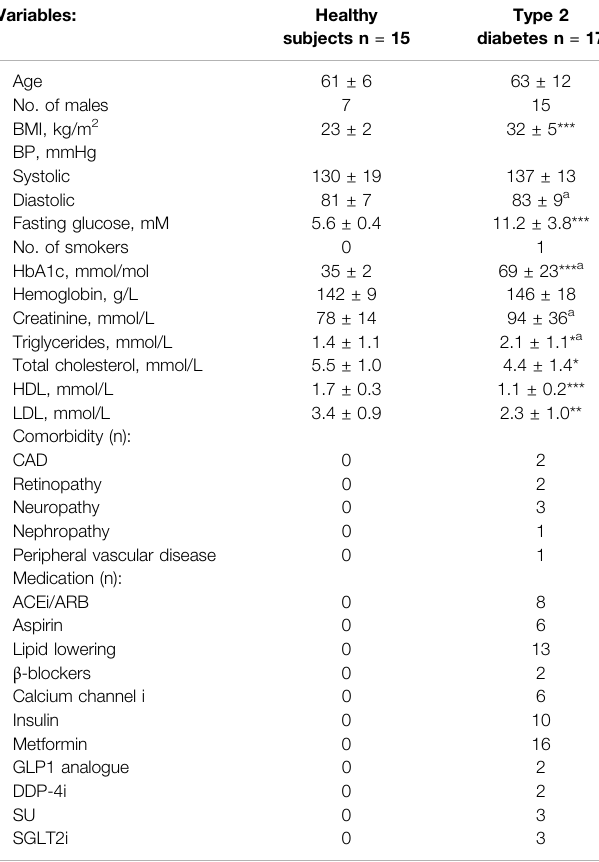
TABLE 1 | Subject characteristics.